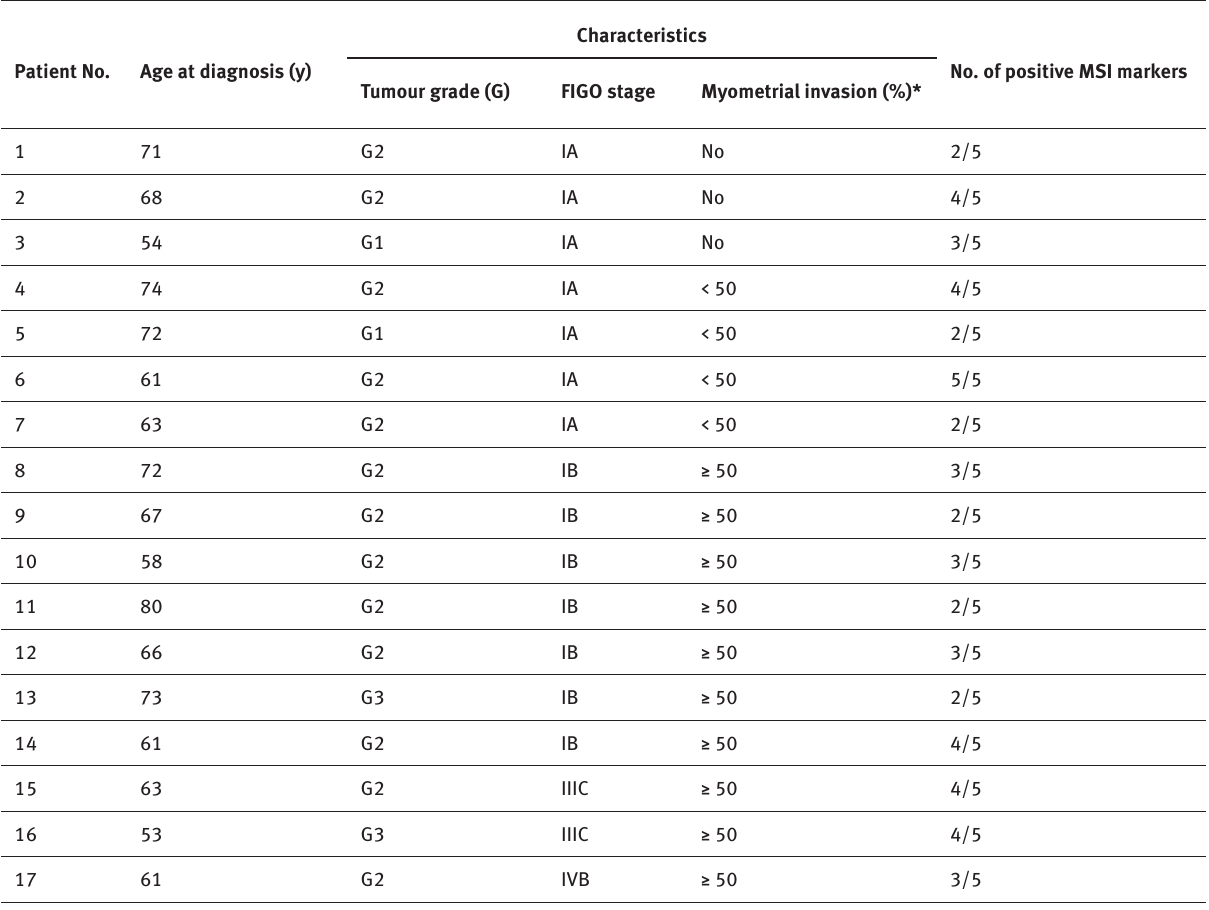
Table 3: Characteristics of each MSI-high sample in endometrioid type adenocarcinomas